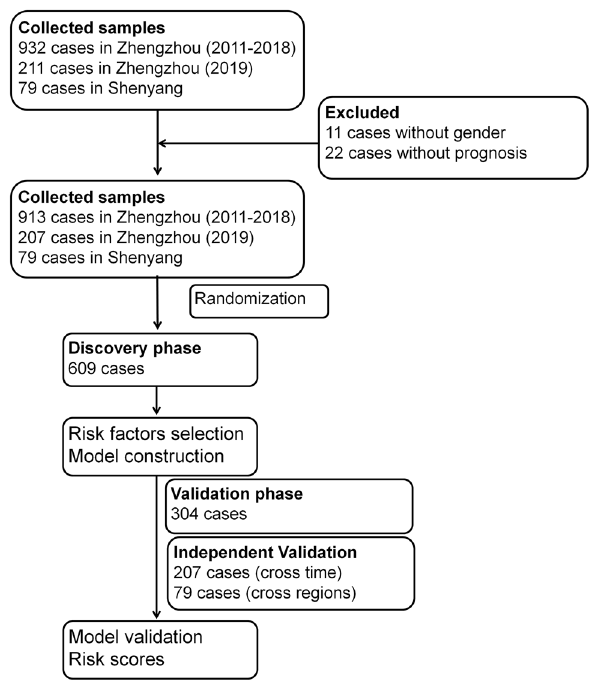
Figure 1. Study design. A total of 932 patients were enrolled during January and February 2019. An additional 207 patients from Zhengzhou 2019 and 79 from Shenyang Shengjing hospital were included as the external validation data sets. Patients without sex (n = 11) and prognosis (n = 22) information were excluded. Then, 913 unique patients were randomly divided into two mutually exclusive samples for training (66.7% [609 patients]) and testing (33.3% [304 patients]). All analyses were conducted using SAS ® statistical software version 9.4 (https